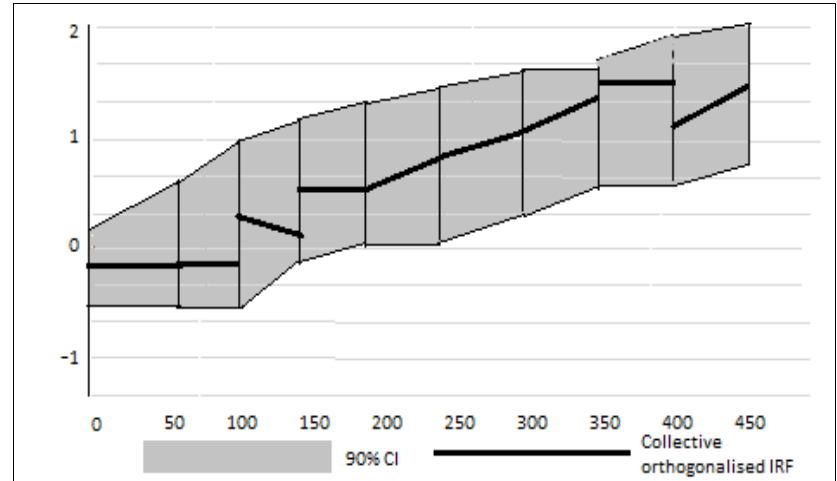
Figure 1. Digital Outbound Marketing.